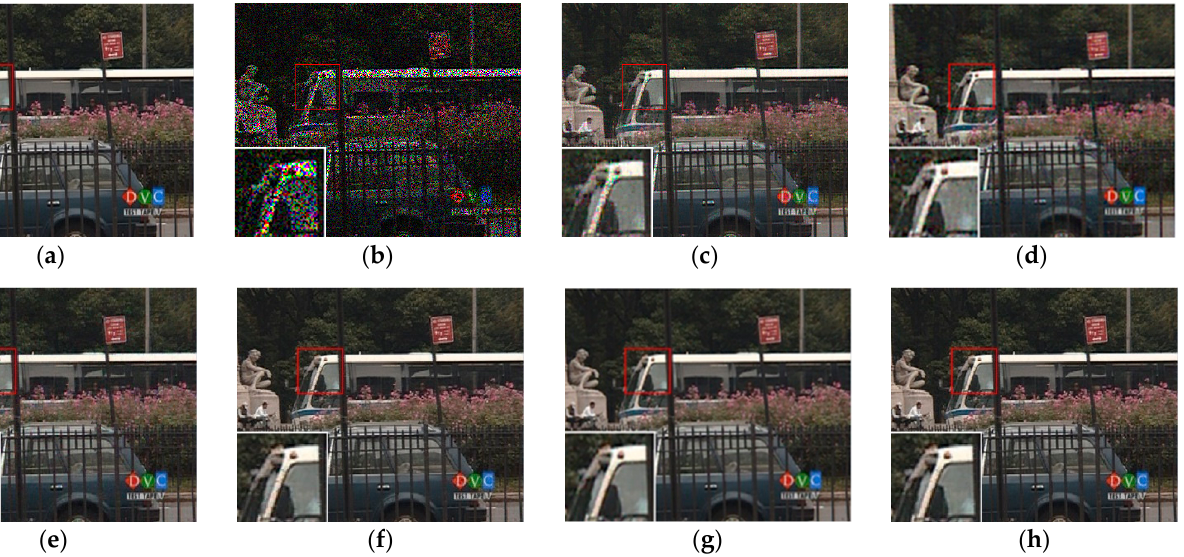
bile video. The incomplete video contains 80% missing entries. (a) Original image; (b) Incomplete